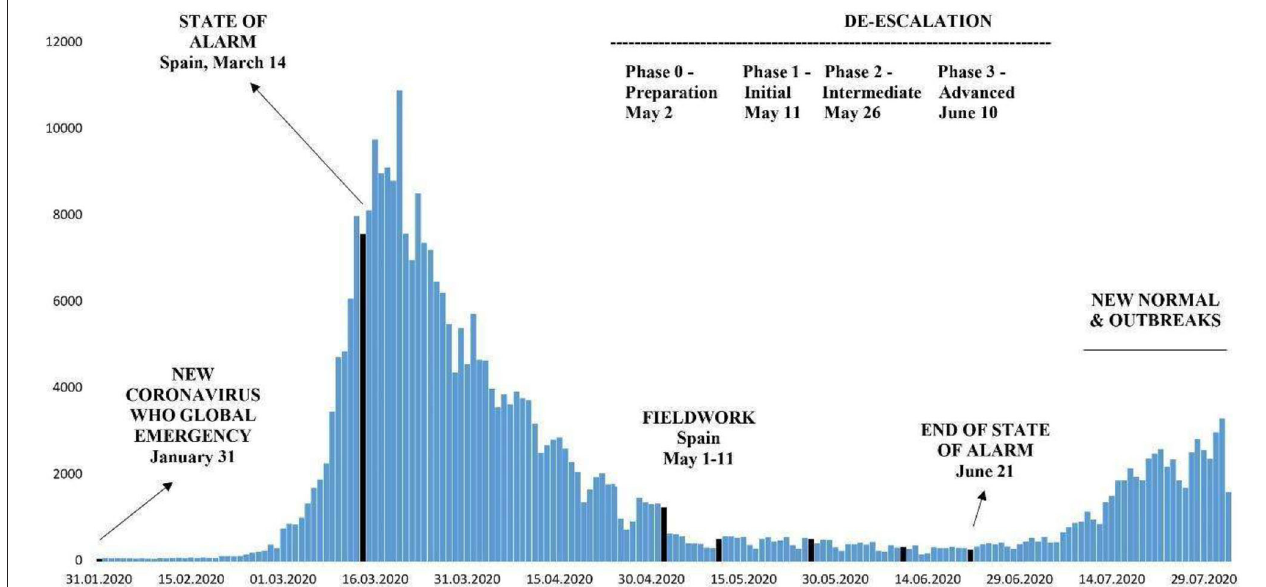
FIGURE 1 | Coronavirus disease-2019 (COVID-19) daily cases in Spain and fieldwork date, 2020. Source: Authors from Ministerio de Sanidad, Consumo y Bienestar Social, cases declared to the Red Nacional de Vigilancia Epidemiológica (RENAVE).